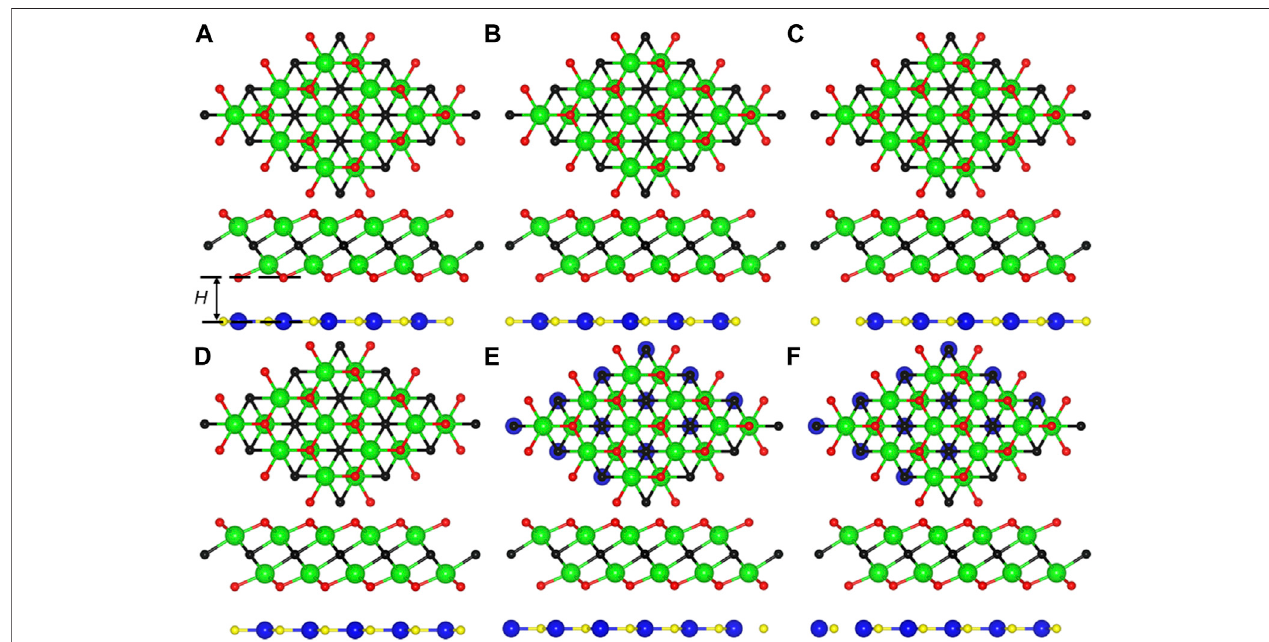
FIGURE1| Thetop and sideviewsofthe (A) AO-1, (B) AO-2, (C) AO-3, (D) AO-4, (E) AO-5, (F) AO-6 stacking con fi gurations for theAlN/Zr 2 CO 2 heterostructure, the blue, yellow, cyan, black and red balls represent the Al, N, Zr, C, and O atoms, respectively.